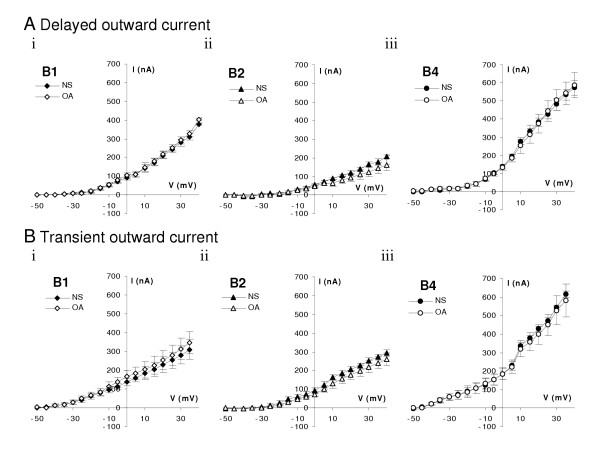
The outward components of the voltage evoked currents are not affected by octopamine. A. Current-voltage relationship of the peak values of the delayed outward currents recorded on B1 (N = 8), B2 (N = 6) and B4 (N = 8) neurons do not show any significant change in the presence of 10 μM octopamine. B. Peak values of the transient outward current component overlap suggesting no significant change of these currents when octopamine (10 μM) is added to the bath, B1 (N = 6), B2 (N = 6) and B4 (N = 8). Normal saline: filled symbols; octopamine: empty symbols. Mean ± SE of currents at end of a 50 ms pulse as in Fig. 2.